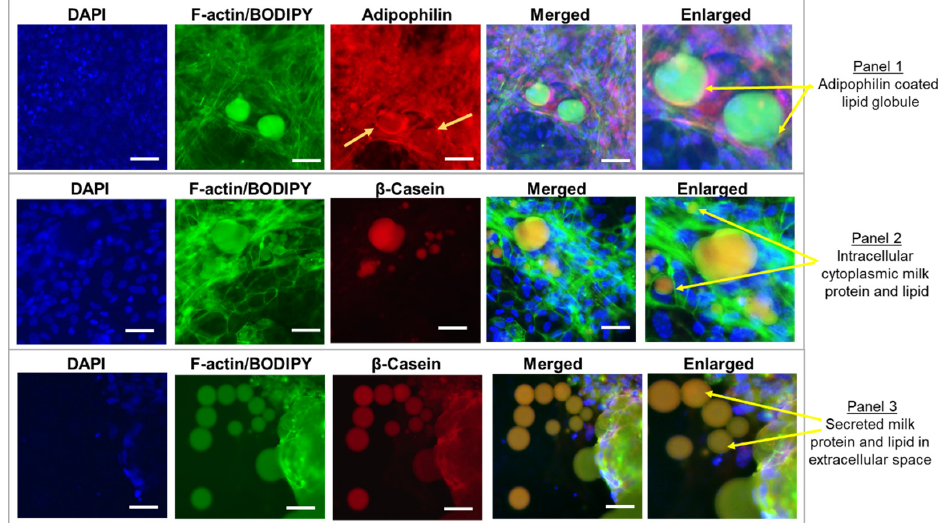
Figure 2. Milk Protein β -casein in Mice Mammary Epithelial Cultures (MEC). Immunostained im- ages of F-actin (green) as a marker of epithelial cells and β -casein (red) as a marker of milk and merged image. Blue represents the nuclei stained with DAPI. Scale bars are 20 μ m.